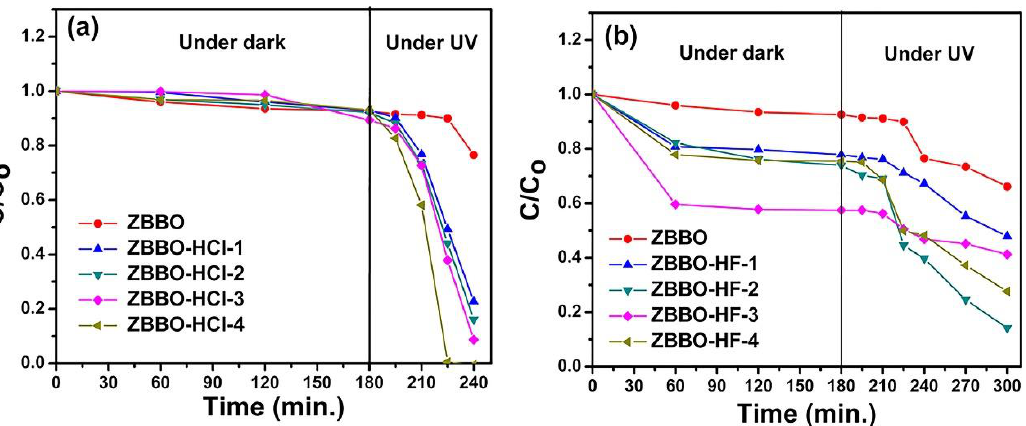
Figure 16. 𝐶 𝐶 0 vs. time plots obtained for ( a ) BiOCl-cyrstallized and ( b ) BiF3-crystallized glass samples during a methylene blue (MB) dye degradation test. Reprinted with permission from Ref. [116].